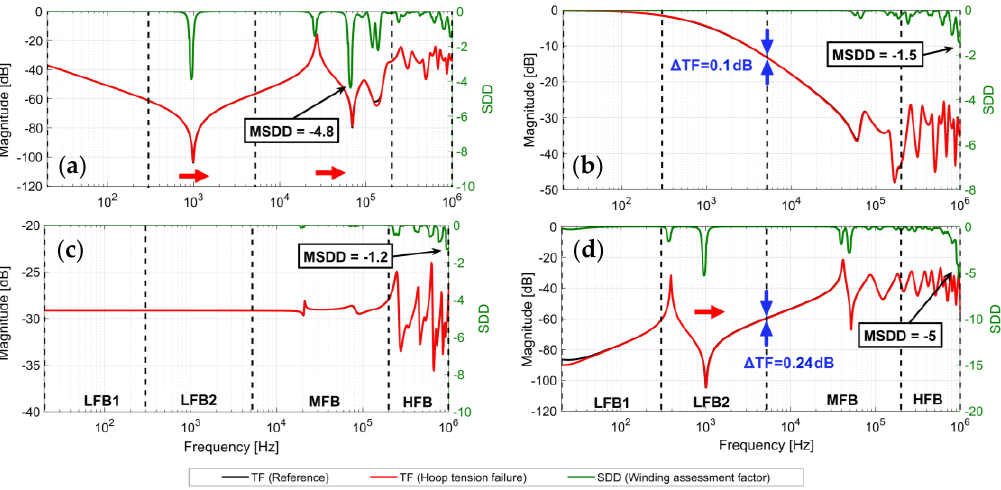
Figure 19. TFs of healthy and deformed (hoop tension failure) B-phase HV winding (vector group YNyn0) and SDD as a measure of deviation between TFs; ( a ) HV-OC, ( b ) HV-SC, ( c ) IIW, ( d ) CIW.